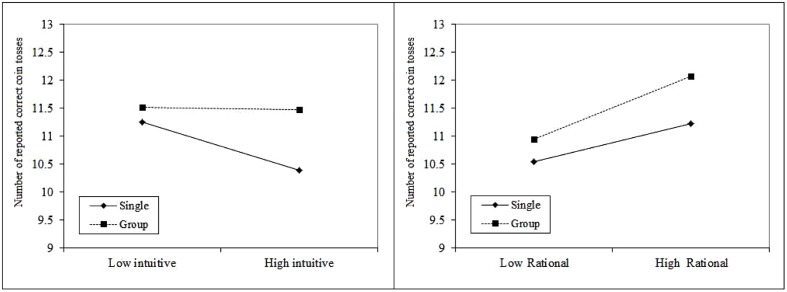
Mean number of reported correct predictions, as a function of Opponent Type and the two REI sub-scales—plotted as recommended by Aiken and West (1991) and Dawson and Richter (2006), one SD below and one SD above the mean of each subscale in each of the Opponent Type conditions.